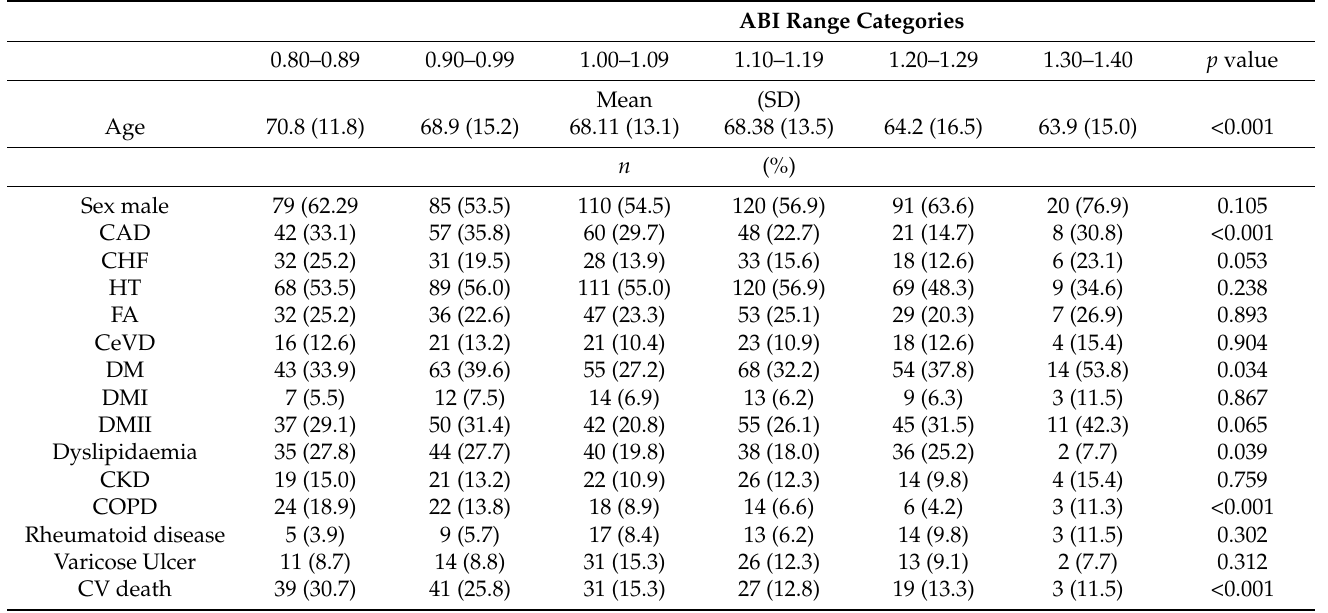
CAD = coronary artery disease, CHF = chronic heart failure, CKD = chronic kidney dysfunction, COPD = chronic obstructive pulmonary disease, CV = cardiovascular, CeVD = cerebrovascular disease, DM = diabetes mellitus,